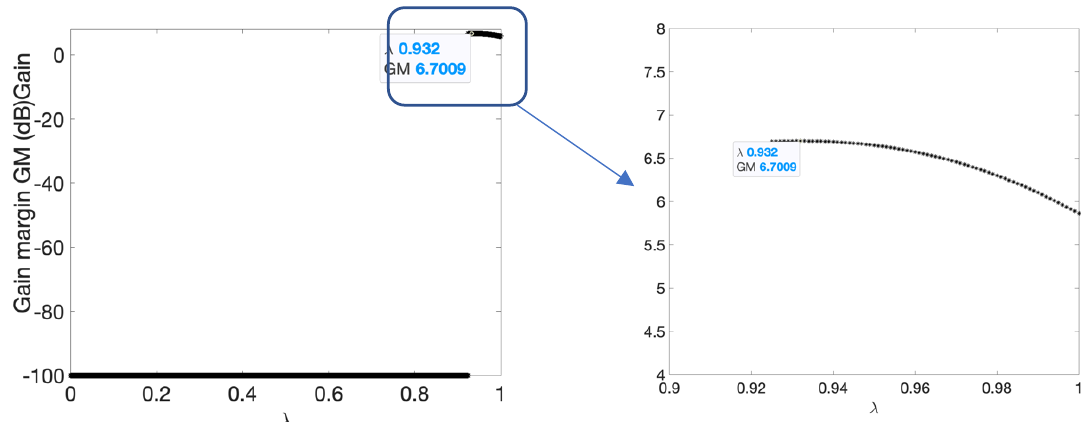
Figure 6. Result of the AFOPI toolbox for the case study.